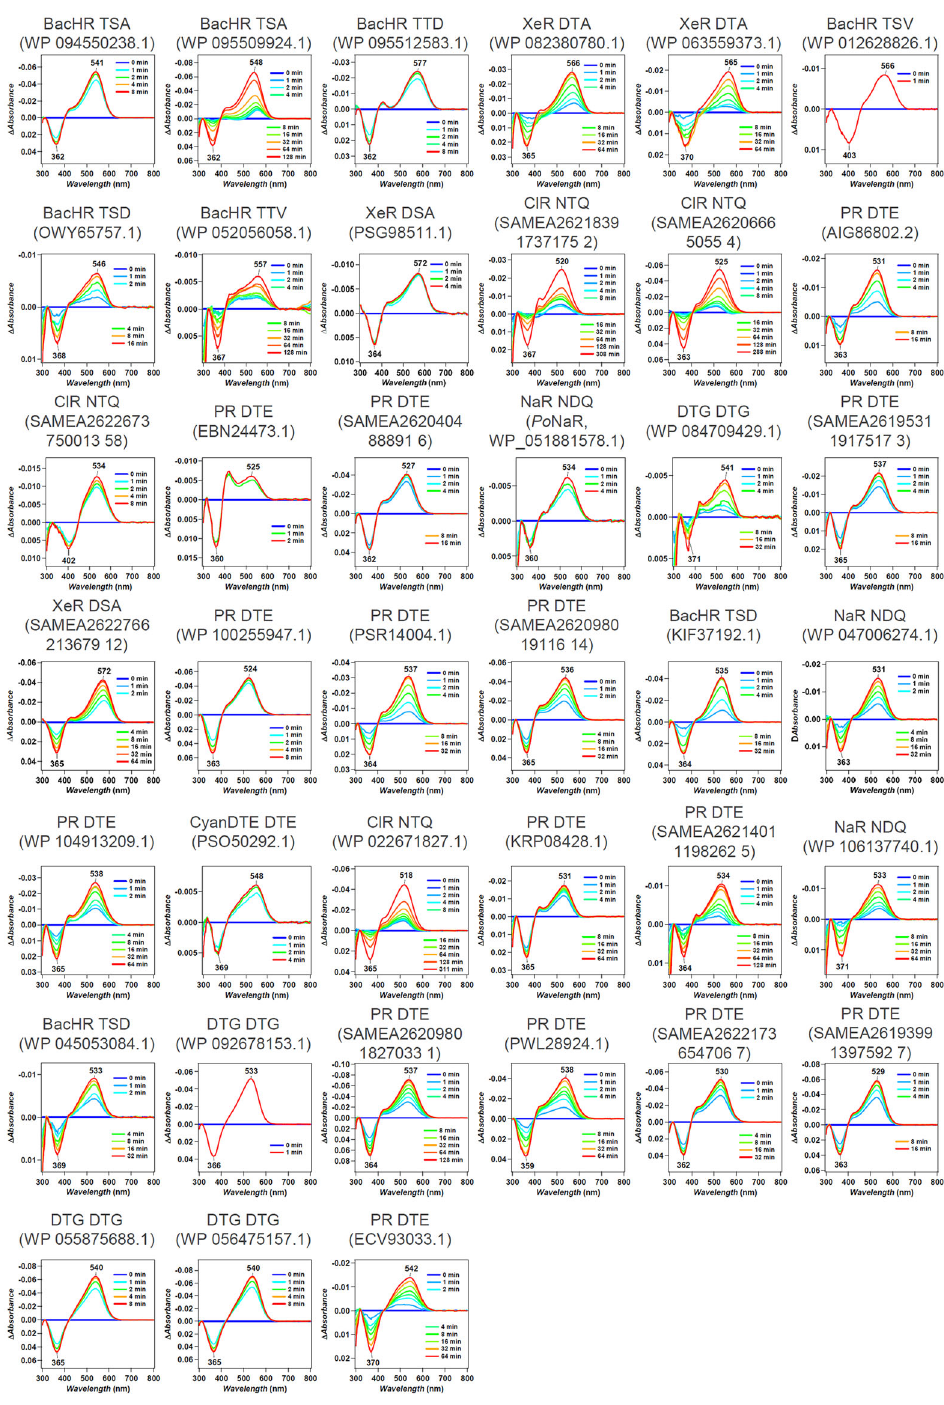
Fig. 4 λ max of 39 microbial rhodopsins in solubilized E. coli membrane observed upon hydroxylamine bleach reaction. The difference absorption spectra between before and after hydroxylamine bleaching reaction of microbial rhodopsins in solubilized E. coli membrane. The λ max of each rhodopsin was determined by the peak positions of the absorption spectra of the original proteins, and the absorption of retinal oxime produced by the reaction of retinal Schiff base and hydroxylamine was observed as a negative peak at ~360 – 370